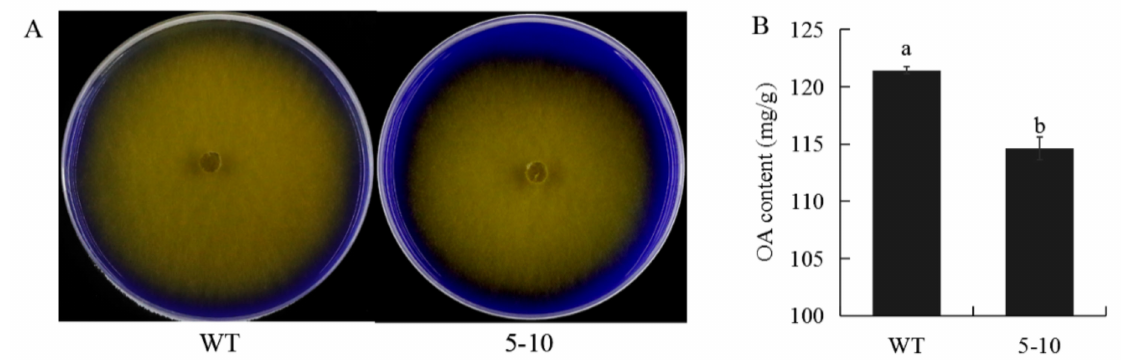
Figure 2. The 5–10 mutant strain produces less oxalic acid (OA). ( A ) Image of mycelia of WT and 5–10 grown on PDA medium containing bromophenol blue. Bar = 10 mm. ( B ) OA content of WT and 5–10 strains. Experiments were conducted at least three times with similar results. Error bars represent SE. Statistical significance was analyzed using Student’s t -test between WT and the 5–10 mutant. a and b represent different significance